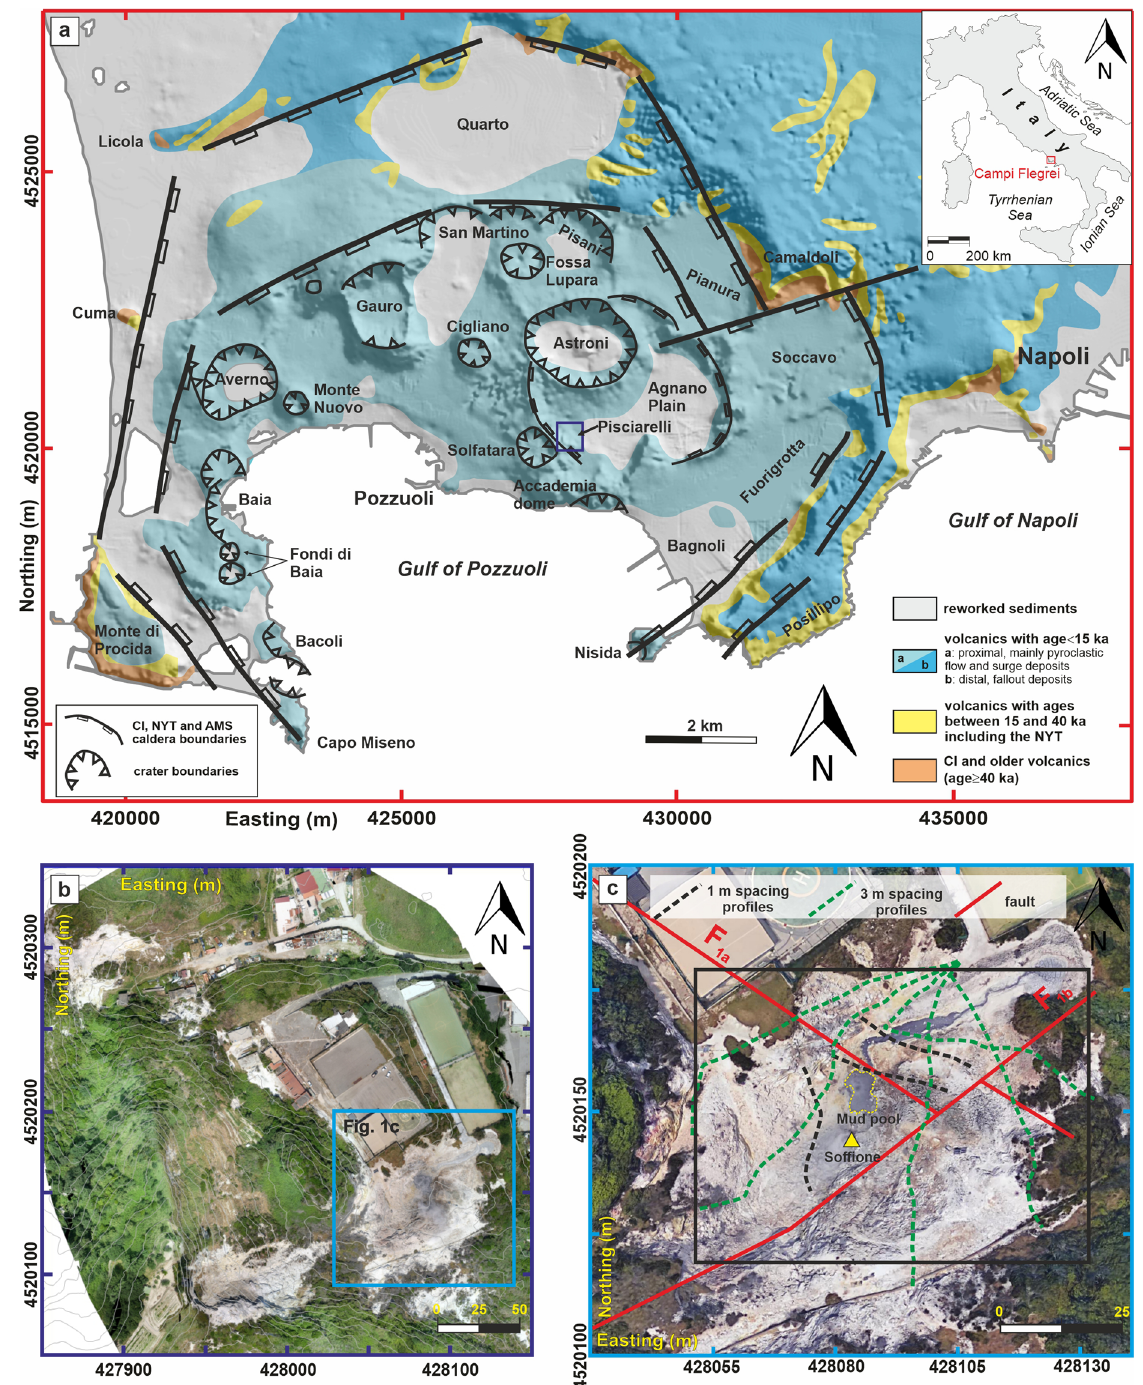
Figure 1. ( a ) Map of the Campi Flegrei caldera (redrawn from ref. 18 ). The blue box delineates the location of the PFF site. ( b ) Aerial view of the PFF. The cyan box shows the study area where the high-resolution ERT and TDIP surveys were carried out. ( c ) Aerial view of the study area in the PFF. The solid red lines indicate the two main fault systems identified by ref. 9 . Green and black dotted lines indicate the locations of the profiles. The yellow triangle indicates the location of the main vent (“Soffione”) (UTM projections, zone 33, datum WGS84, m). The figure was created using the MATLAB R2020b commercial software (https:// www. mathw orks. com/ produ cts/ MATLAB. html) and postprocessed using the Corel Draw 17 commercial software (https:// www. corel draw. com/ it/ produ ct/ corel draw/). The aerial view of Pisciarelli was produced by the Istituto Nazionale